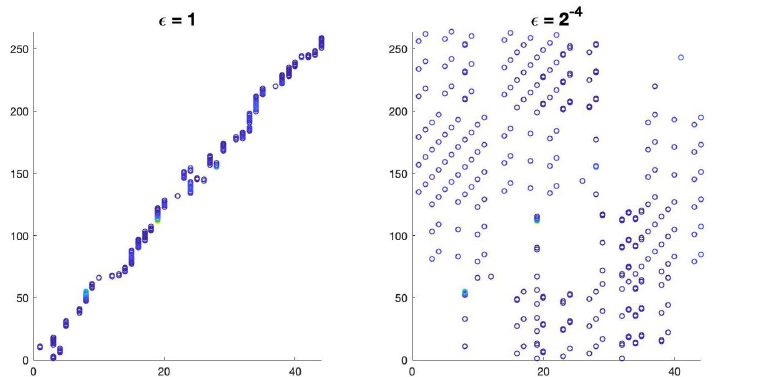
Figure 3. Test 2. Visualization of measured data whose intensity value is above 0.05 × max i , j { d i , j }